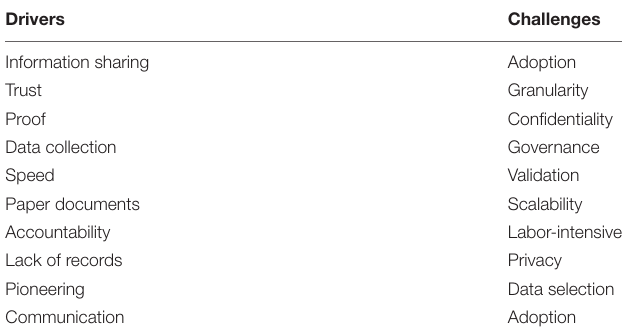
TABLE 5 | Traceability drivers and challenges.